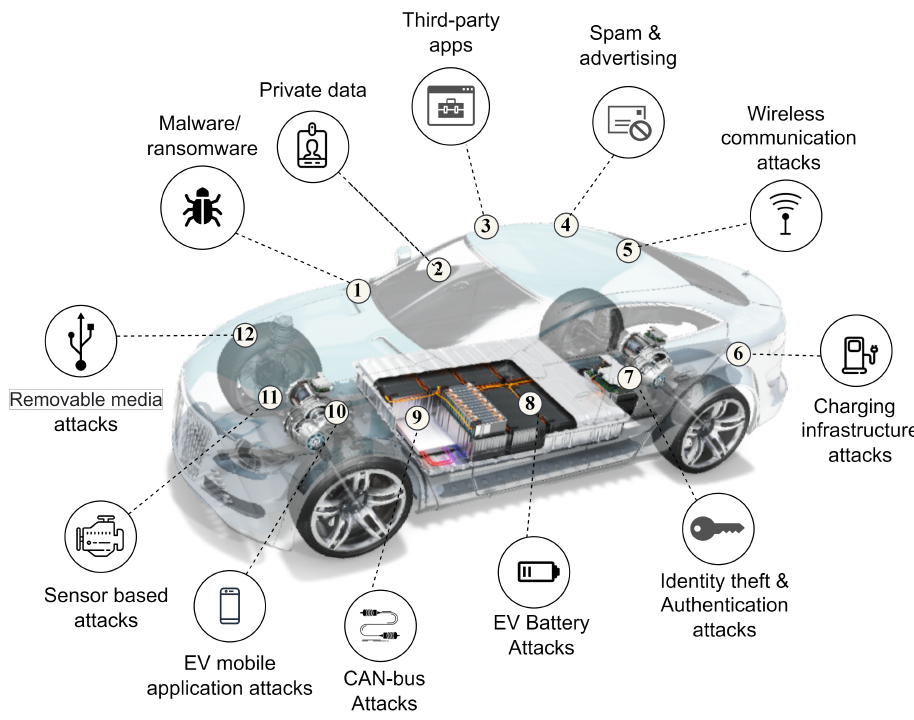
Figure 4. Illustration of security threats and cyber attacks targeting